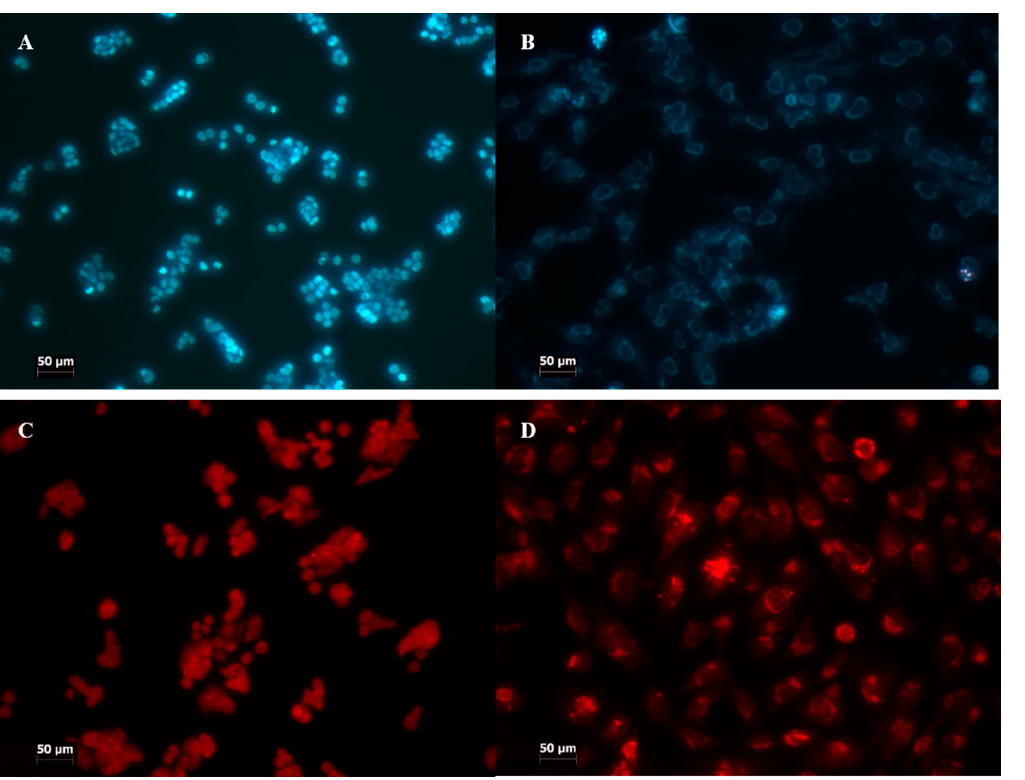
Figure 4. Staining for different kinds of cell death analysis. ( A , B ) staining with propidium iodide and Hoechst 33342; ( C , D ) staining with acridine orange; ( A , C ) HT29; ( B , D ) CCD 841 CoTr. The fluorescence was excited at the wavelength λ = 420 nm. Cells were treated with porphyrins at a concentration of 10 µ M and exposed to white light irradiation for 3 min. The cells stained blue were identified as living, whereas a significant intensity of fluorescence with the presence of nuclear graininess confirmed apoptosis induction. Cells stained red were assumed to be dead. Magnification 100 × . Bar = 50 µ